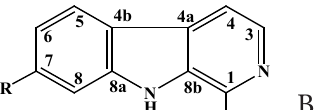
=H, R =R =O, 7 ) and indole-type alkaloids (B): 1 2 3 , 4 ) and harmane (1-methyl-β-carboline; R=H, 8 3